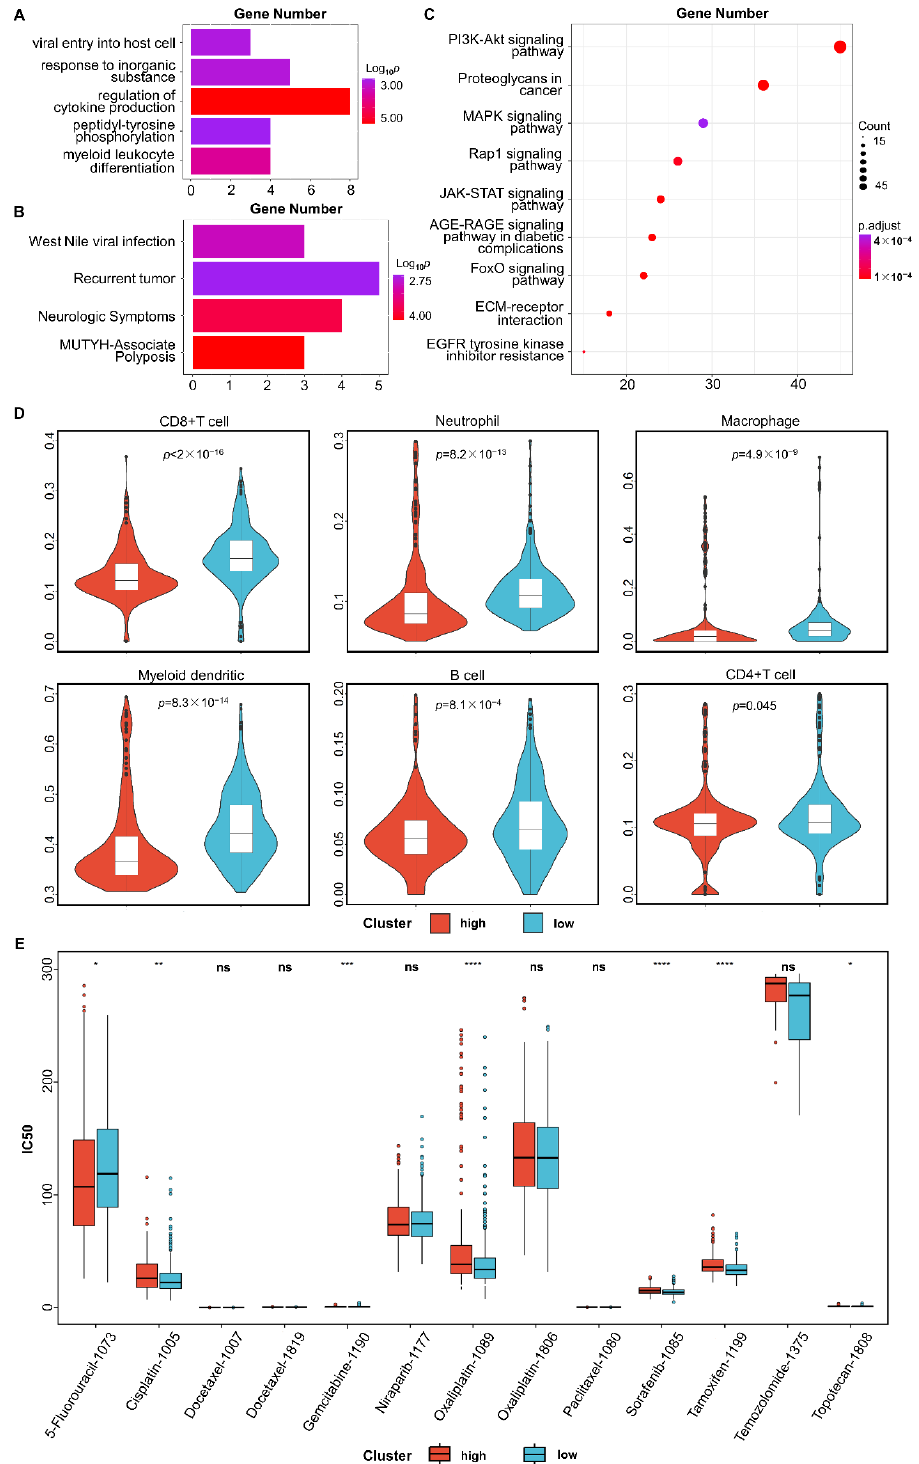
Figure 3. Functional enrichment and immune infiltration analysis. ( A ) Significant GO biological processes enriched by SOV-P20. ( B ) Significant DisGeNet pathways enriched by SOV-P20. ( C ) Signif- icant KEGG pathways enriched by differentially expressed genes between the high- and low-risk groups divided by SOV-P20. ( D ) Vioplot of the difference in the infiltration scores of CD8+ T cells, neutrophils, macrophages, myeloid dendritic, B cells, and CD4+ T cells. ( E ) The difference in drug response between the high- and low-risk groups divided by SOV-P20.The legend is as following: ns, non-significant; * p < 0.05; ** p < 0.01; *** p < 0.001; **** p <